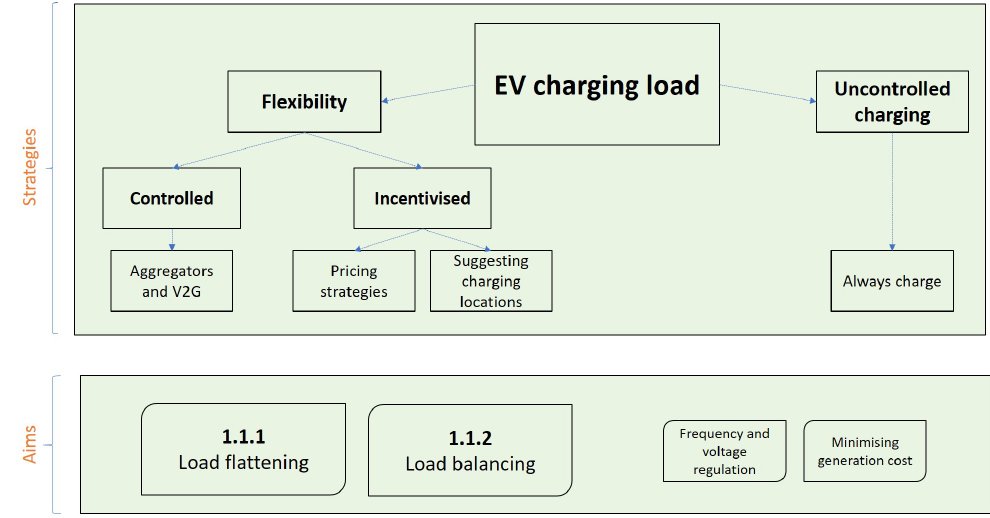
Figure 1. The variety of strategies envisaged for handling Electric Vehicle (EV) load and their associated